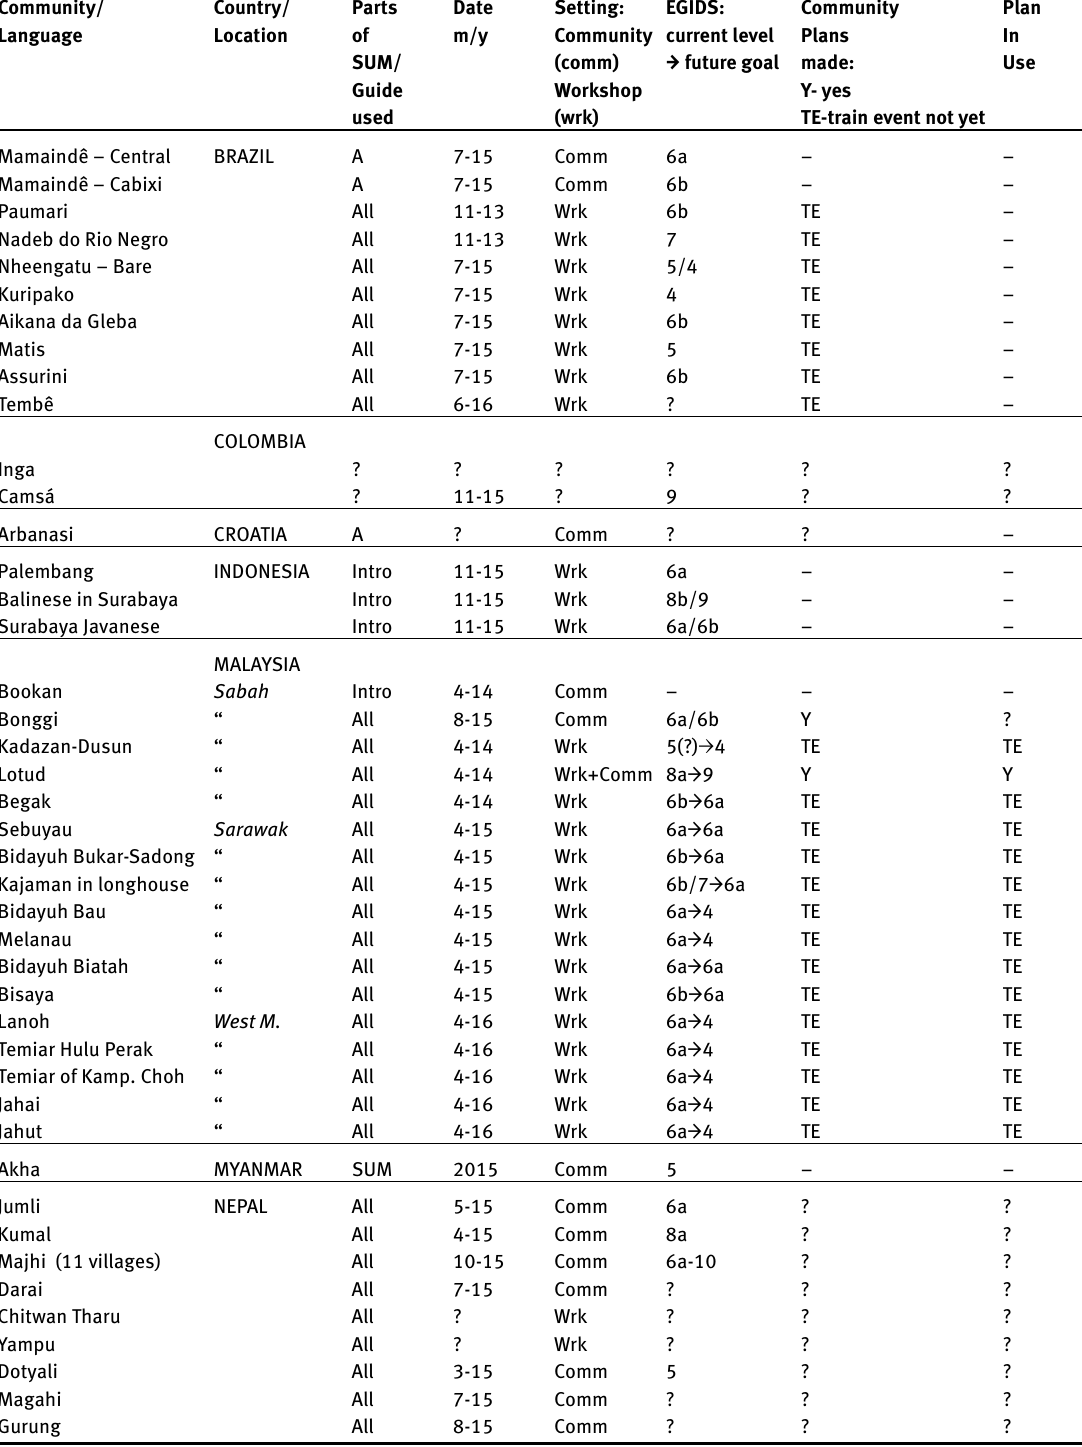
Table 2. Community applications of the ‘Guide for Planning the Future of our Language’